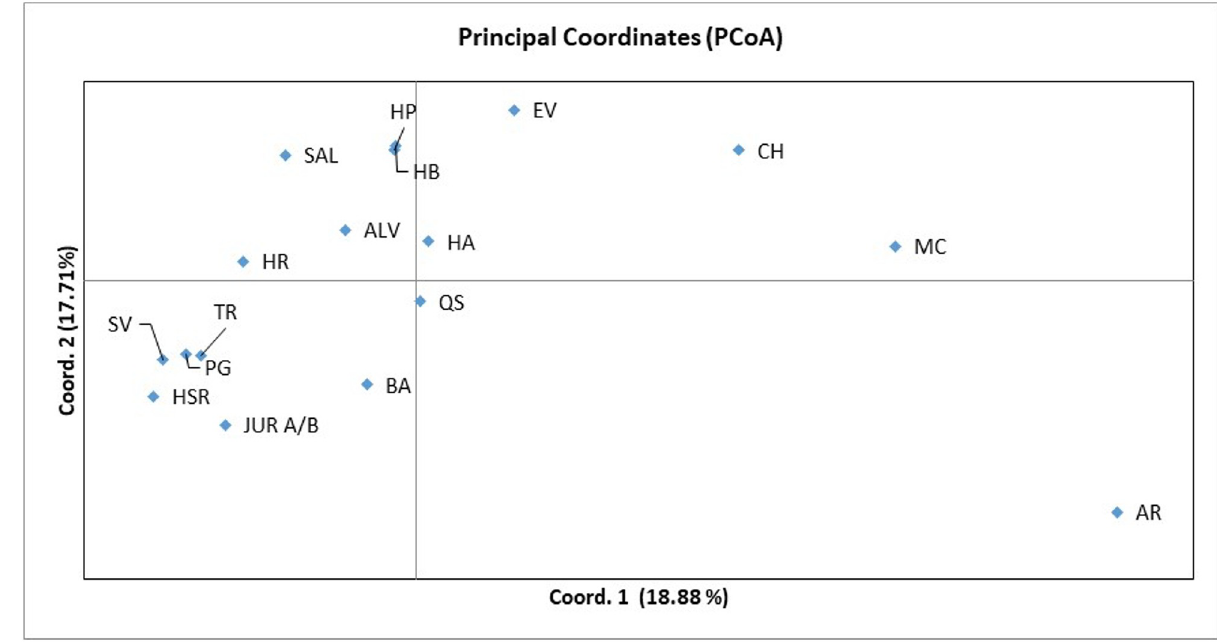
Fig 2. Principal coordinate analysis of Nei’s genetic distance for the 17 geographic populations of Cynara cardunculus